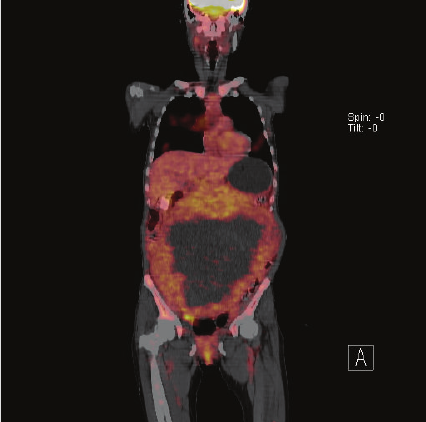
Figure 2: F-18 fludeoxyglucose (FDG) positron emission tomogra- phy/computed tomography (PET/CT)